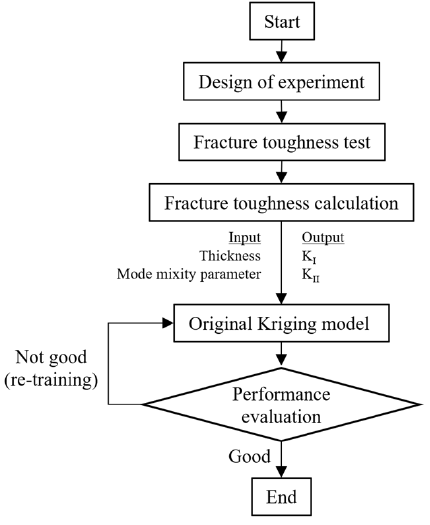
Figure 7. The modeling process of the original Kriging model. The Or-K model can be predicting using the unknow function ˆ y ( X ) as